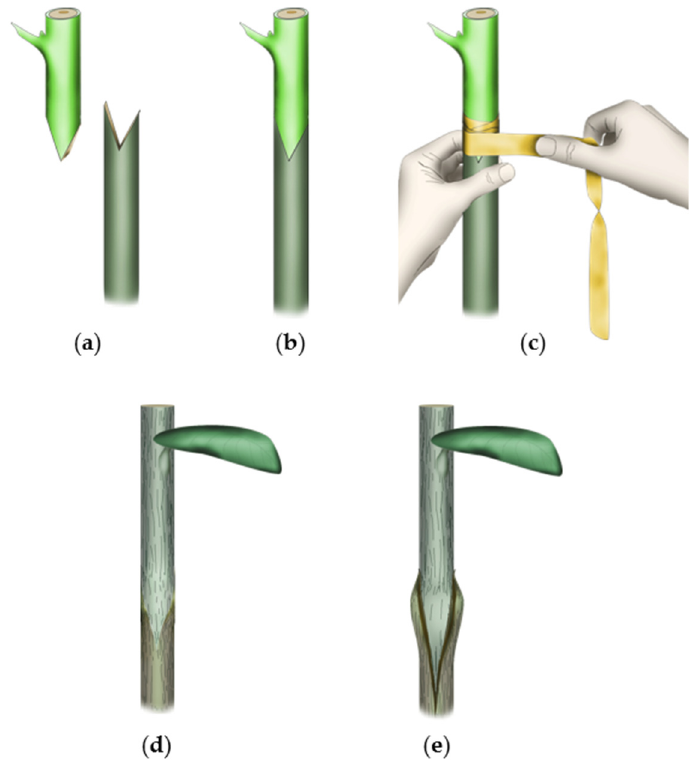
Figure 1. A typical grafting (wedge) procedure. The scion and rootstock cut surfaces are properly aligned ( a , b ) and the union is covered with grafting tape ( c ) to support the union establishment. Depending on the graft partners, the normal graft establishment ( d ) in tree species could take weeks. ( e ) Incompatible combinations of graft partners with differential growth rates may exhibit swollen graft union.